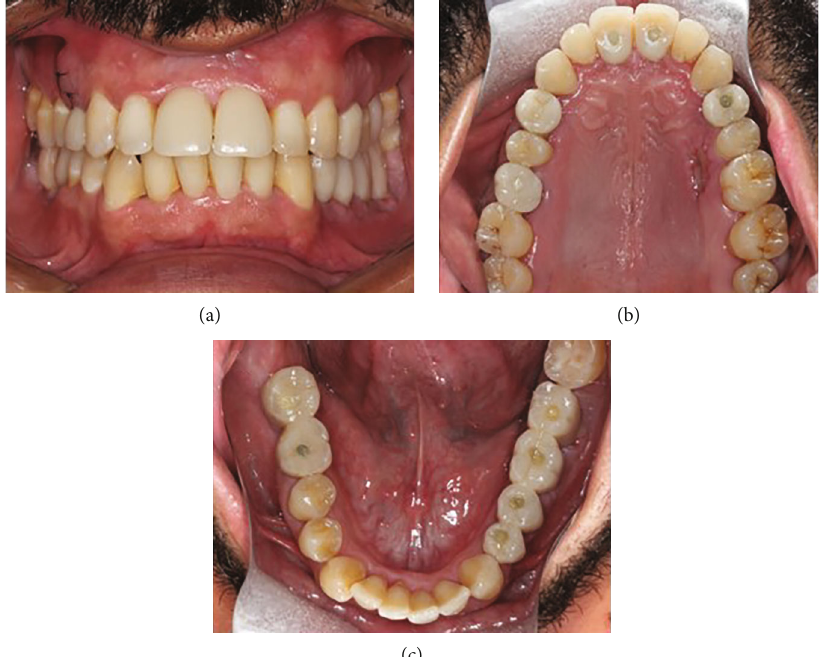
Figure 4: Clinical aspects at the time of immediate loading. Frontal view in occlusion (a), maxillary (b), and mandibular (c) occlusal view of acrylic resin temporary crowns.